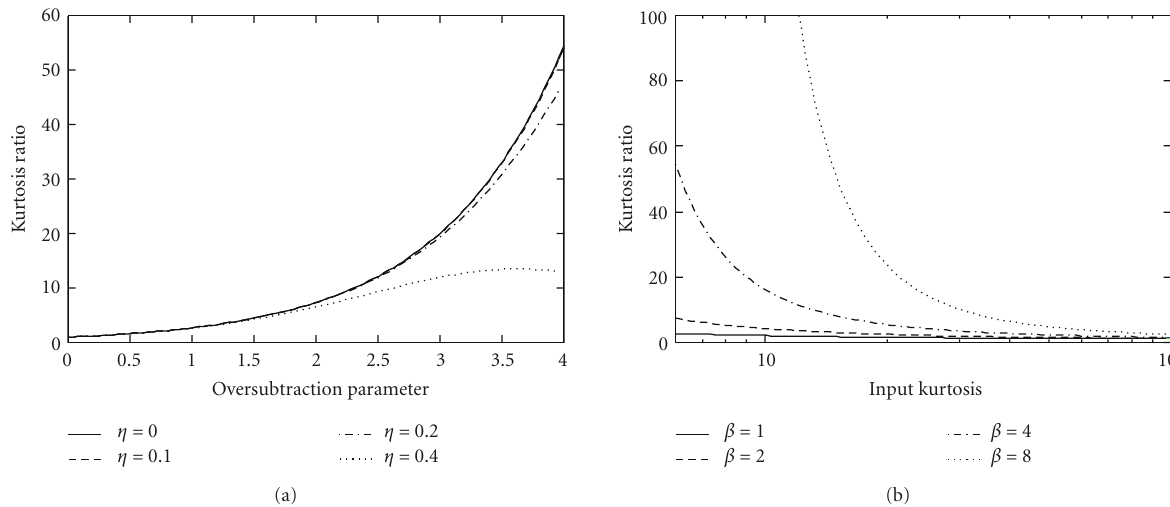
Figure 6: (a) Theoretical kurtosis ratio after SS for various values of oversubtraction parameter β and flooring parameter η . In this figure, kurtosis of input signal is fixed to 6.0. (b) Theoretical kurtosis ratio after SS for various values of input kurtosis. In this figure, flooring parameter η is fixed to